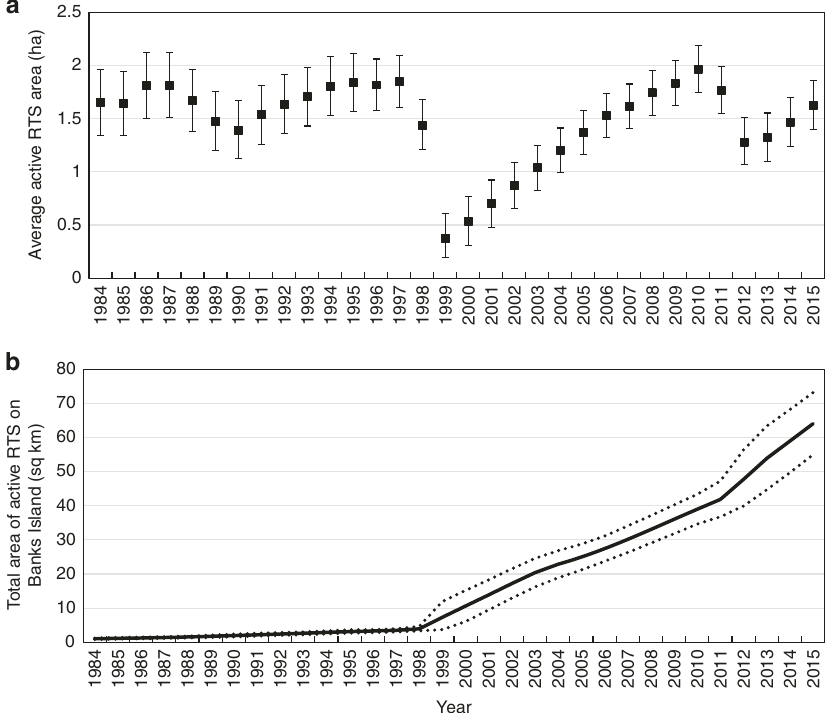
Fig. 4 Calculated area of active retrogressive thaw slumps on Banks Island (1984 – 2015). a Average feature area based on population age distribution in each year and the area-age relationship in Fig. 3b. Error bars are 95% con fi dence intervals. b Total area of active retrogressive thaw slumps. Dotted lines are 95% con fi dence intervals